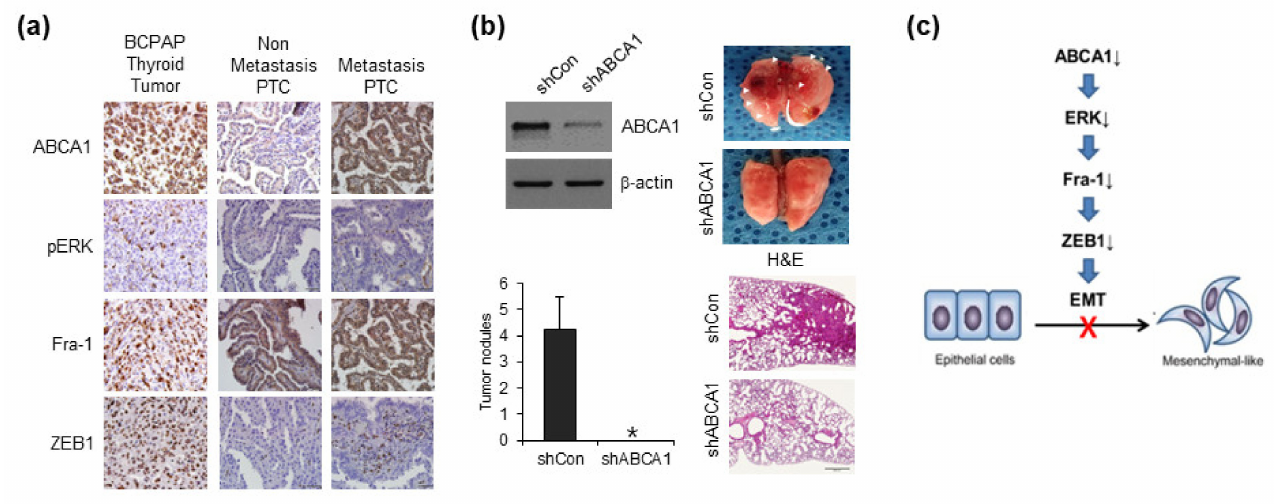
Figure 6. ABCA1 is associated with lung metastasis. ( a ) Representative images indicating protein- stained tumor tissues from mice injected with BCPAP cells and patients with thyroid cancer. Scale bar: 100 µ m. ( b ) Cell lysates from BCPAP cells stably expressing control short hairpin RNA (shRNA: shCon) or ABCA1 shRNA (shABCA1) were analyzed via immunoblotting (upper). A representative image of histological analysis of the lungs isolated from mice injected with shCon in the tail vein or ABCA1-knocked-down (shABCA1) BCPAP cells (left). Arrowheads and hematoxylin and eosin (H&E) staining images indicate lung metastatic nodules (right). Data were quantified by counting the number of surface lung nodules (upper left). Error bars indicate the means ± S.E.M. * p < 0.05 versus shCon (Student’s t -test). ( c ) Proposed model for the regulation of EMT by ABCA1. In the absence of ABCA1, decreased expression of Fra-1 is due to reduced ERK activity, which leads to decreased Fra-1 binding to the promoter region of ZEB1 EMT-TF. This reduces the expression of ZEB1, and the reduced expression of ZEB1 suppresses